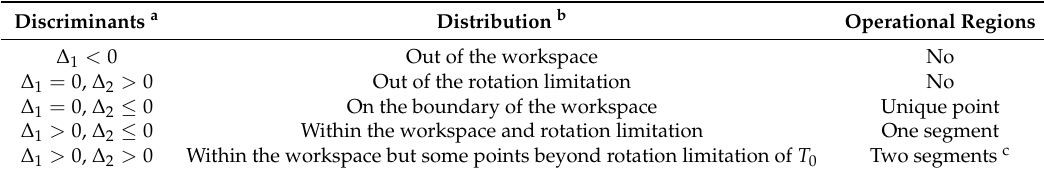
Table 1. Discriminants corresponding to the distribution of operational regions for